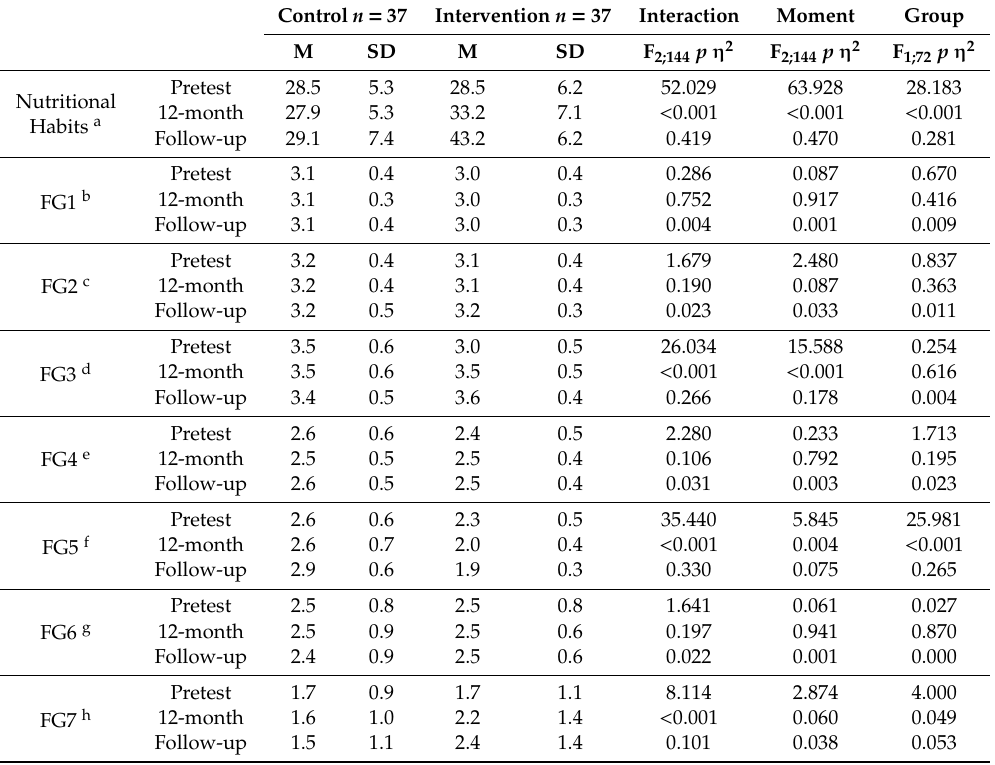
Table 2. E ff ect of the intervention on the parameters of nutritional habits.